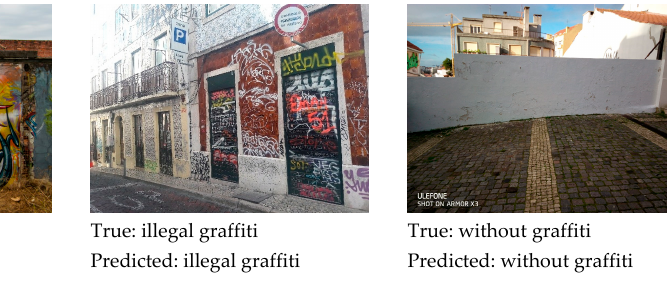
Figure 12. Examples of correctly classified images .